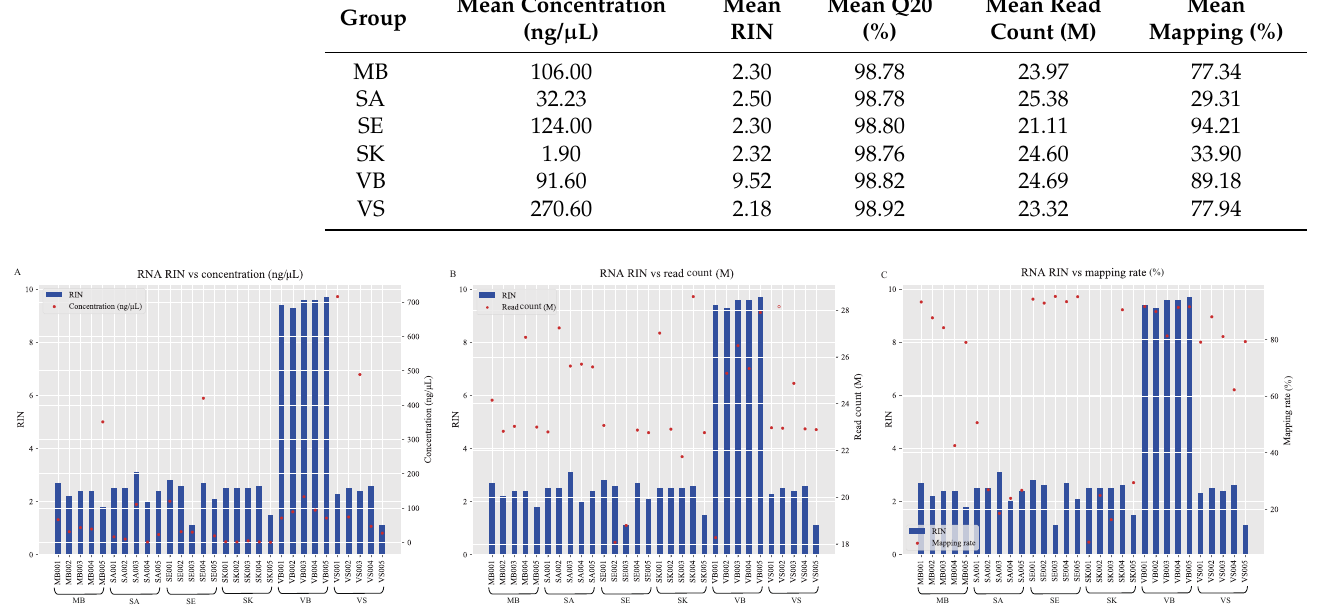
Figure 1. A comparison of the RIN value with the corresponding concentration ( A ), read count ( B ), and mapping rate ( C